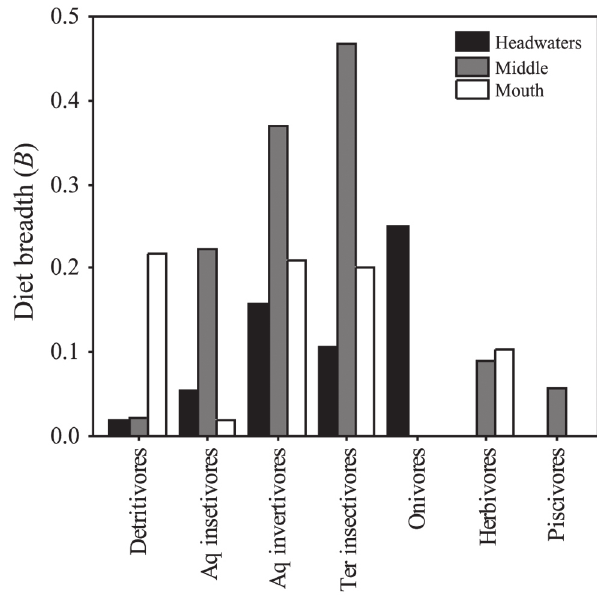
Fig. 5. Longitudinal niche breadth ( B values) of each fish trophic guild in the Vermelho River, East Atlantic basin, Antonina, Paraná State, Brazil. Aq = aquatic; ter = terrestrial.